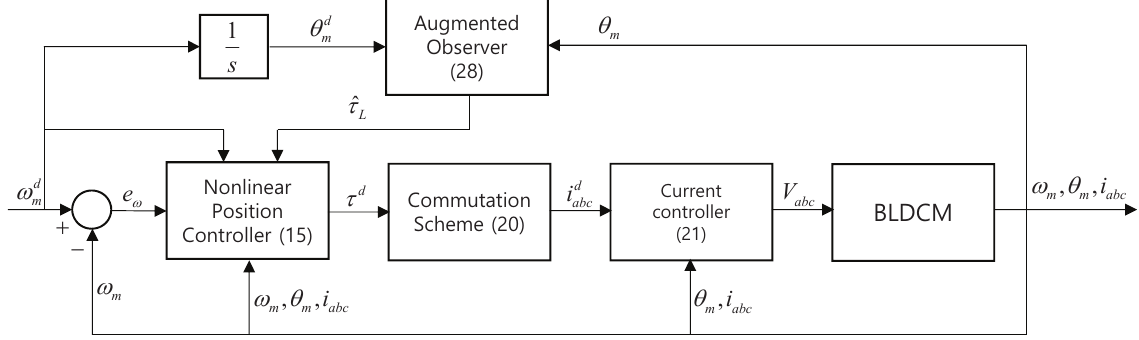
Figure 3. Control block diagram of the proposed